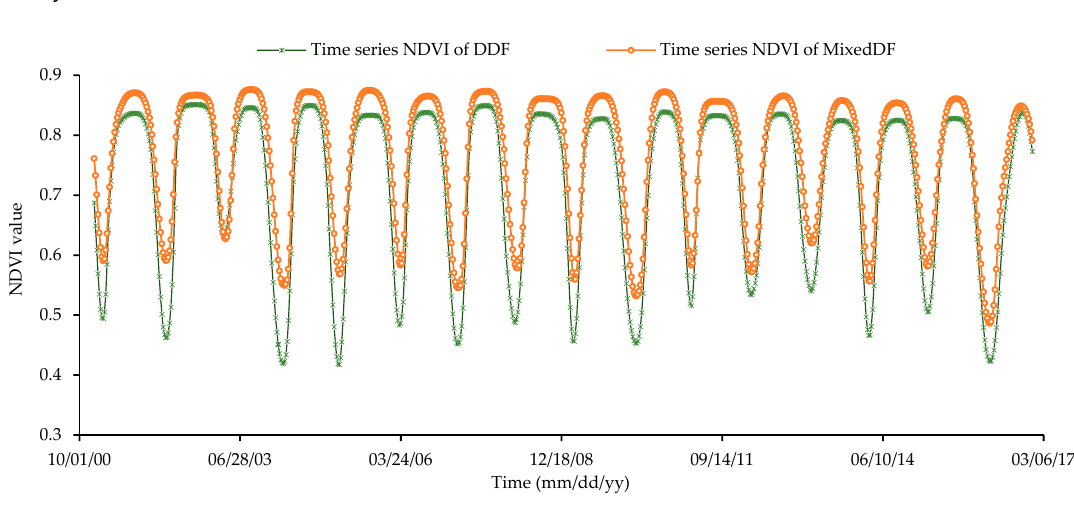
Figure 9. Example of seasonal different in NDVI timing values of DDF ( green ) and MDF (red) period 2001–2016 .